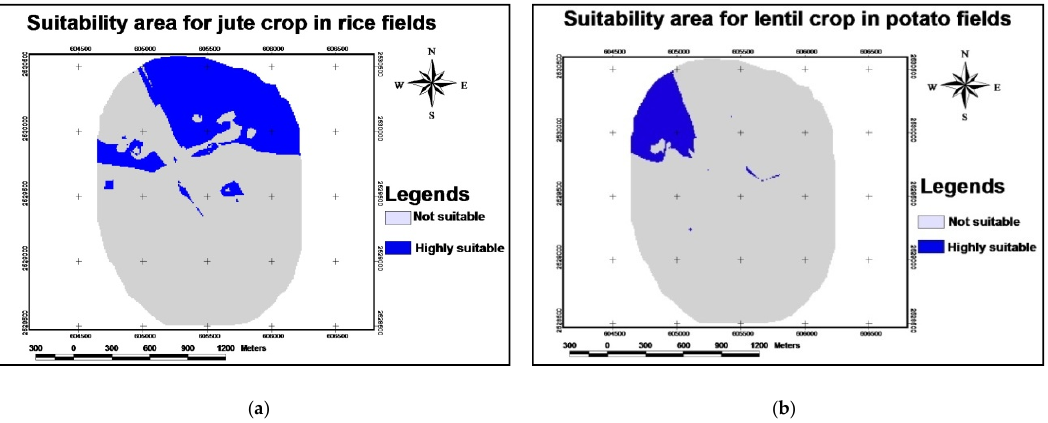
Figure 7. Crop recommendation based on suitable area distribution analysis; ( a ) jute in rice area, ( b ) lentil in potato area.